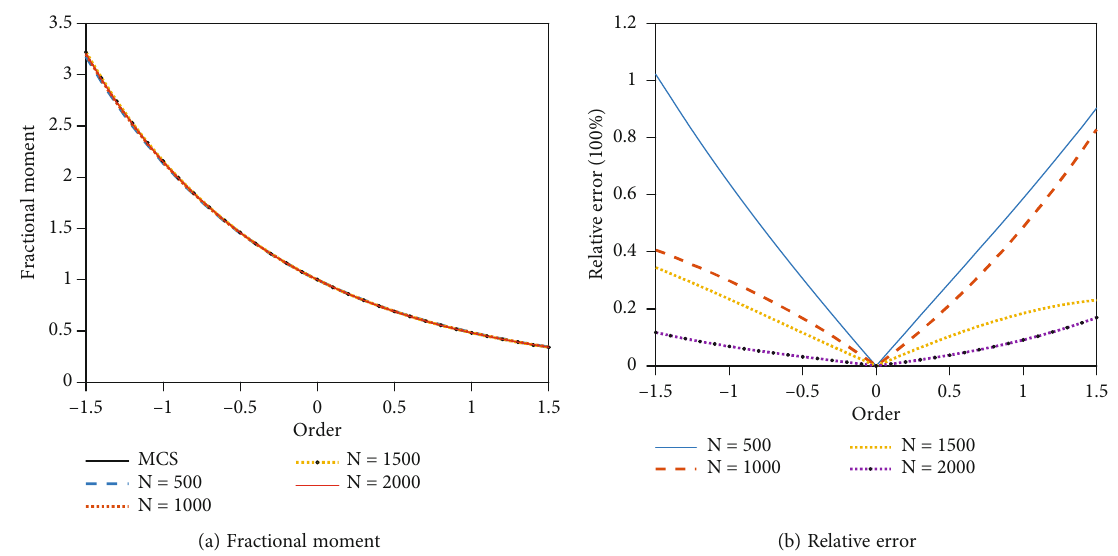
Figure 3: Fractional moments and relative error of the normalized response (the SDOF oscillator). Table 1: The value of the objective function without penalty term.